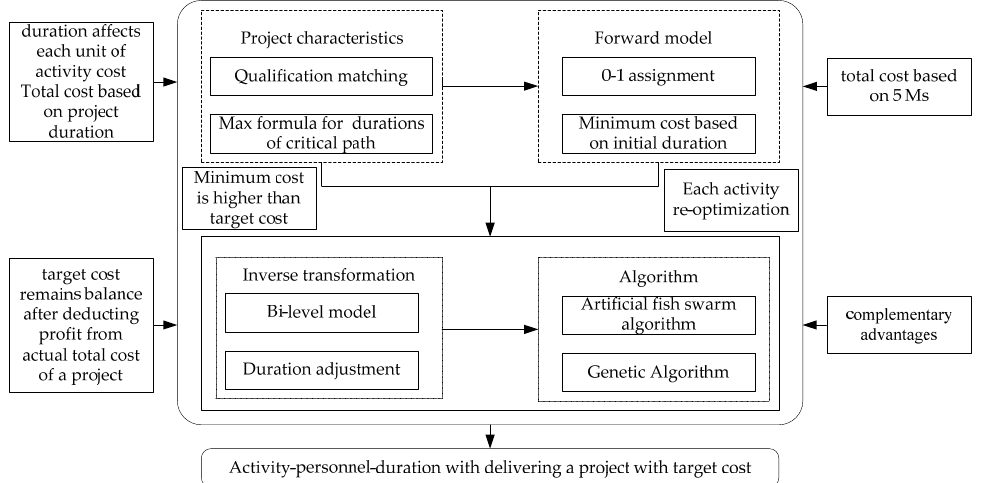
Figure 1. Framework of the inverse optimal value method.